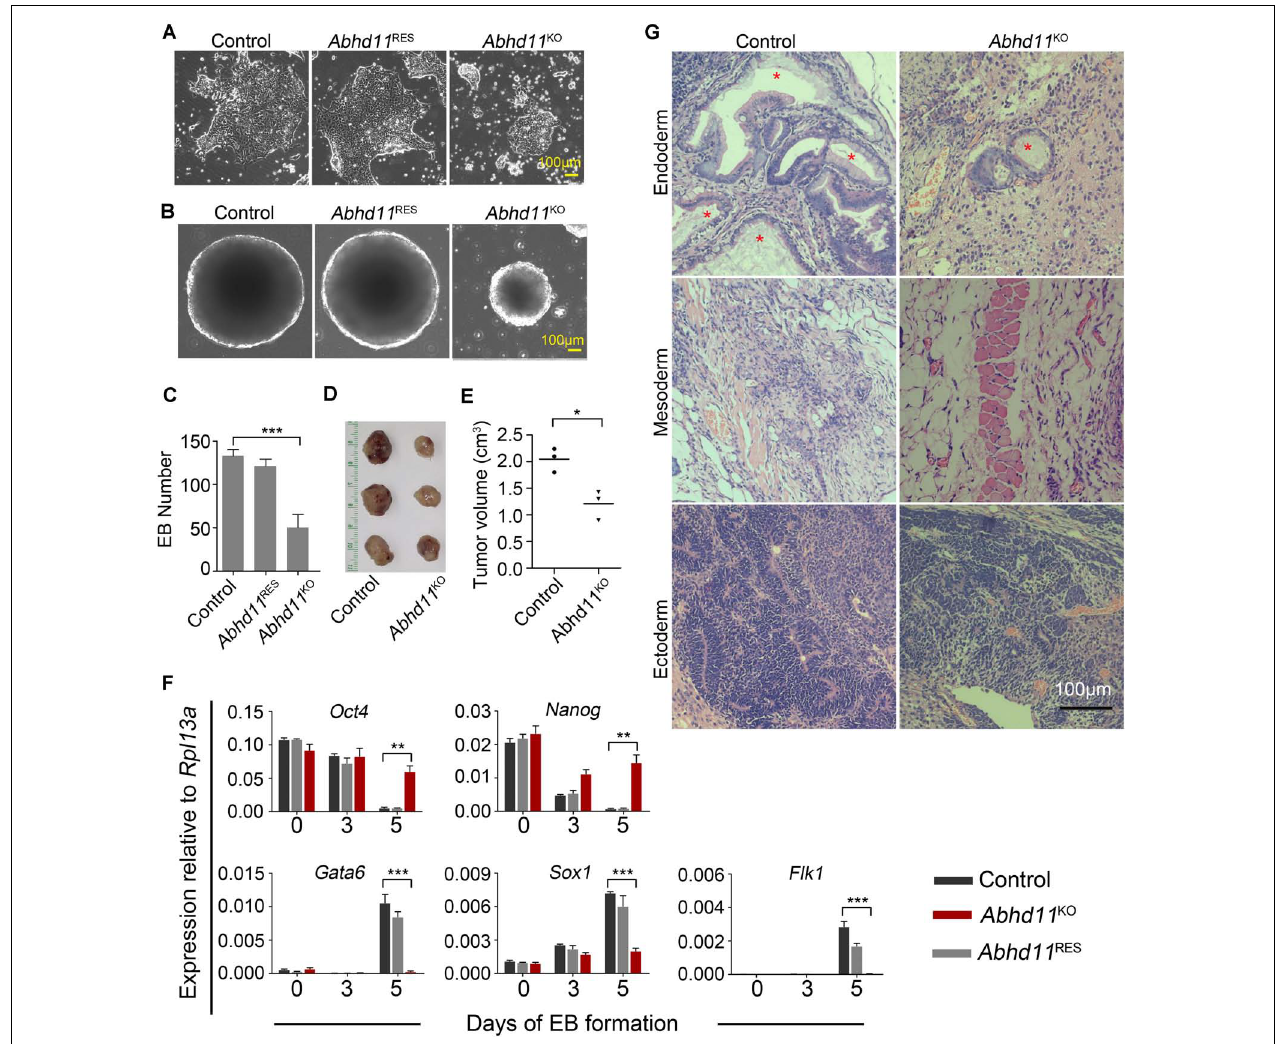
FIGURE 5 | ABHD11 is necessary for the full execution of differentiation programs. (A) Representative images of the indicated cells cultured for 4 days in the absence of LIF. (B) Representative images of EBs formed by the indicated cells at day 5. (C) Quantification of EBs formed by the indicated cells at day 5. (D) Teratomas formed from the control and Abhd11 KO ESCs. Teratomas were collected 4 weeks after the injection of ESCs subcutaneously into nude mice. (E) The volume of teratomas presented in panel (D) . (F) qRT-PCR analysis of expression levels of pluripotency and germ layer marker during the course of EB formation. The EBs were collected at Day 0, 3, 5 during the course of EB formation. All data were normalized to Rpl13a . (G) Teratoma section were stained with hematoxylin/eosin. Asterisks indicate typical endodermal epithelium–like structures (simple columnar epithelium). Data in panels (C , F) were represented as means ± s.d.; n = 3. * p < 0.05, ** p < 0.01, *** p <